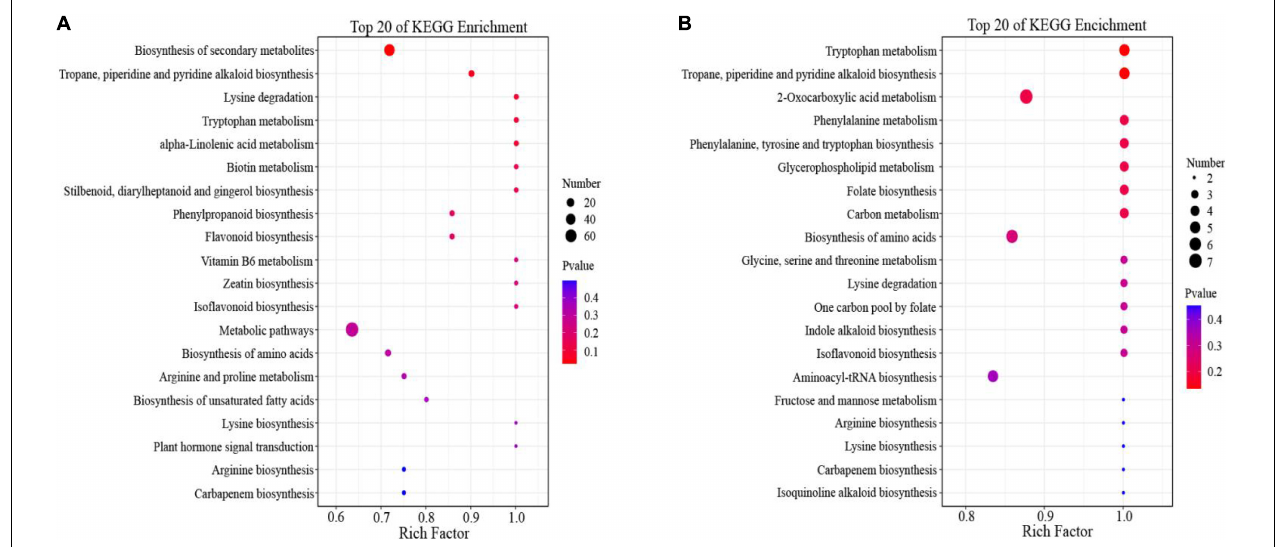
FIGURE 5 | Functional Kyoto Encyclopedia of Genes and Genomes (KEGG) pathway classification of differentially expressed metabolites (DEMs) in (A) positive ion mode and (B) negative ion